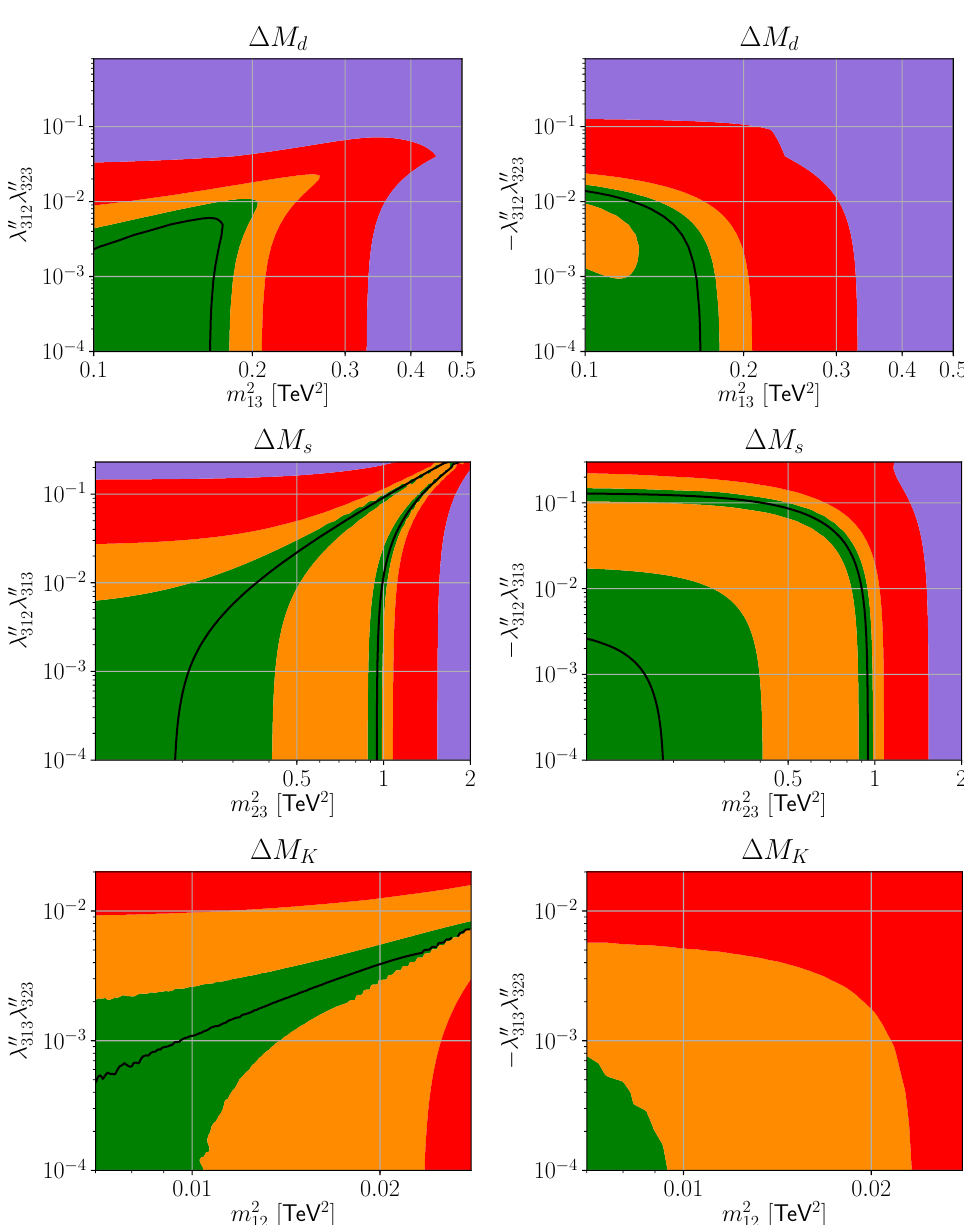
Figure 10. Constraints from the meson-oscillation parameters in the presence of both (cid:13)avor- violating (cid:22) U (cid:22) D (cid:22) D -couplings and (cid:13)avor-violating squark mixing. The parameters are set to the scenario SUSY-RpV(a) from table 1. The color code is unchanged compared to previous plots.